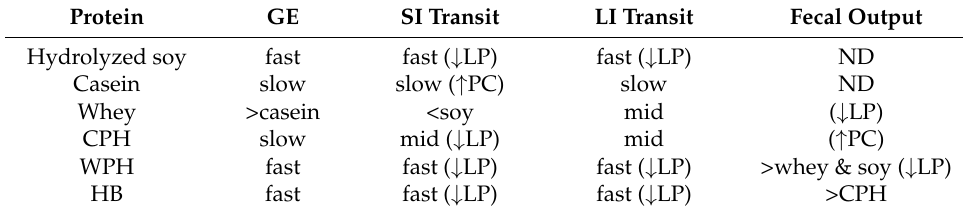
Table 2. Summary of altered GI function.